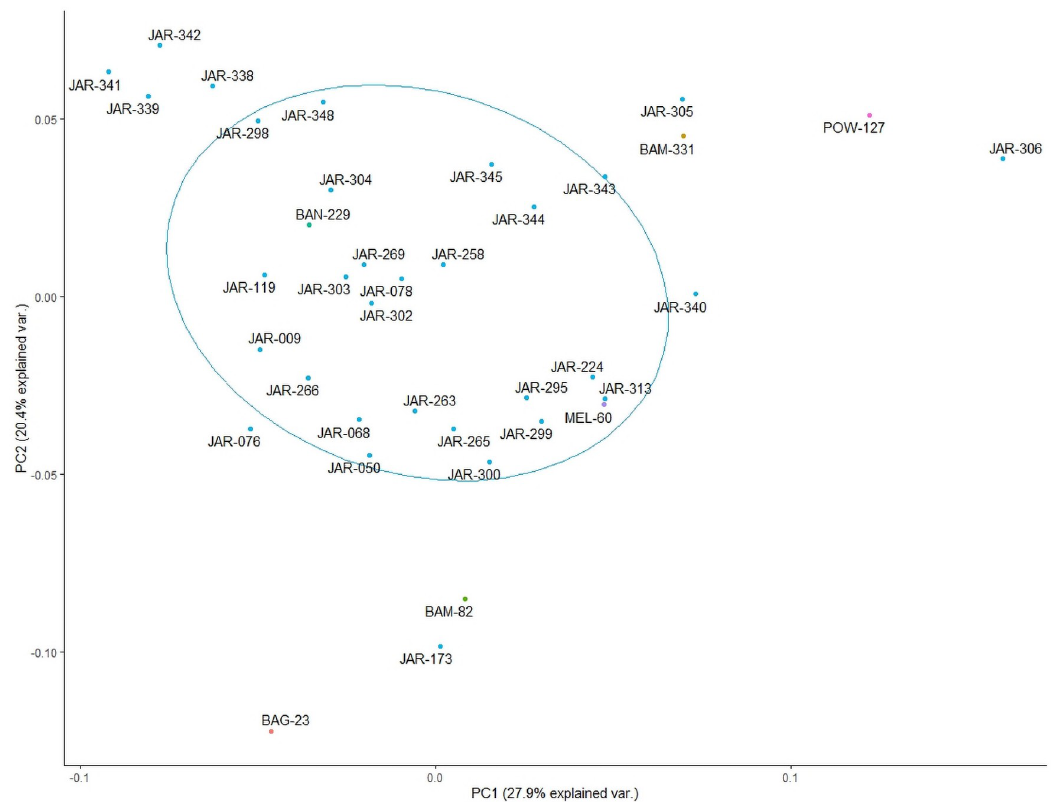
Fig 3. Second step of cluster analysis (identification of preliminary JAR core